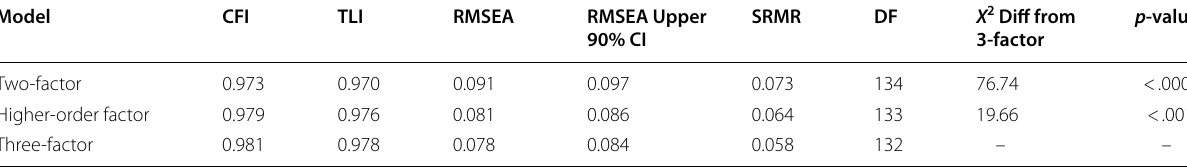
Table 4 Confirmatory factor analysis model fit statistics after removing PSTEBS_5 and PSTEBS_7 Model